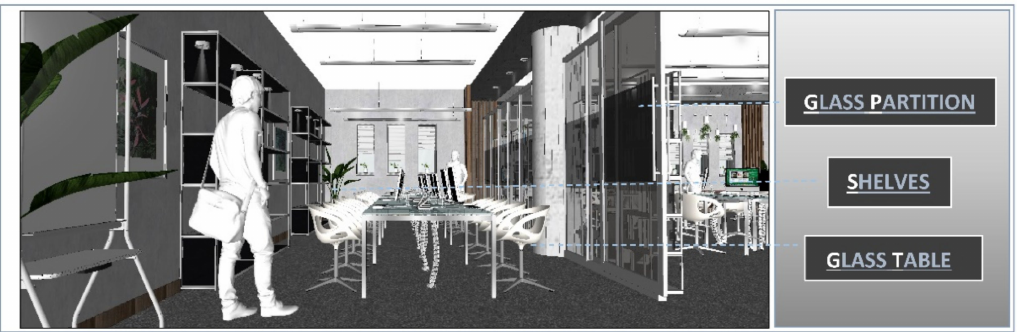
Figure 12. Internal perspective of an online search room before modification.